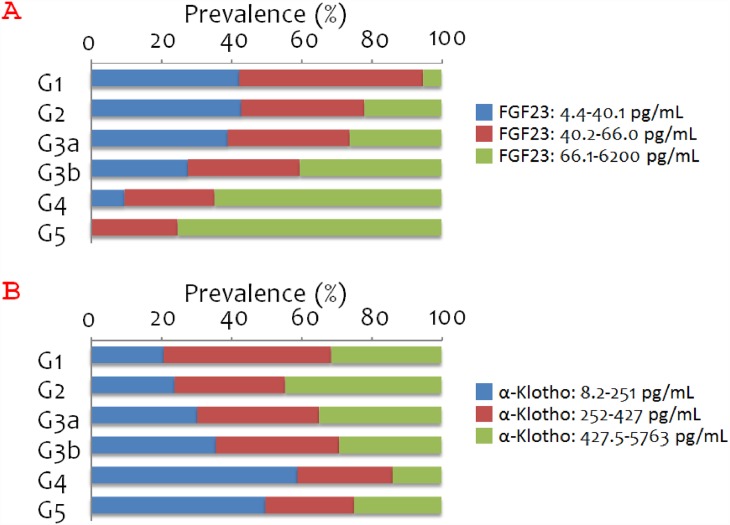
Prevalence of each FGF23 or α-Klotho tertile by CKD stage.A. Percentage of patients in each FGF23 tertile according to CKD stage (P<0.001 by χ2 test). B. Percentage of patients in each α-Klotho tertile according to CKD stage (P<0.001 by χ2 test).